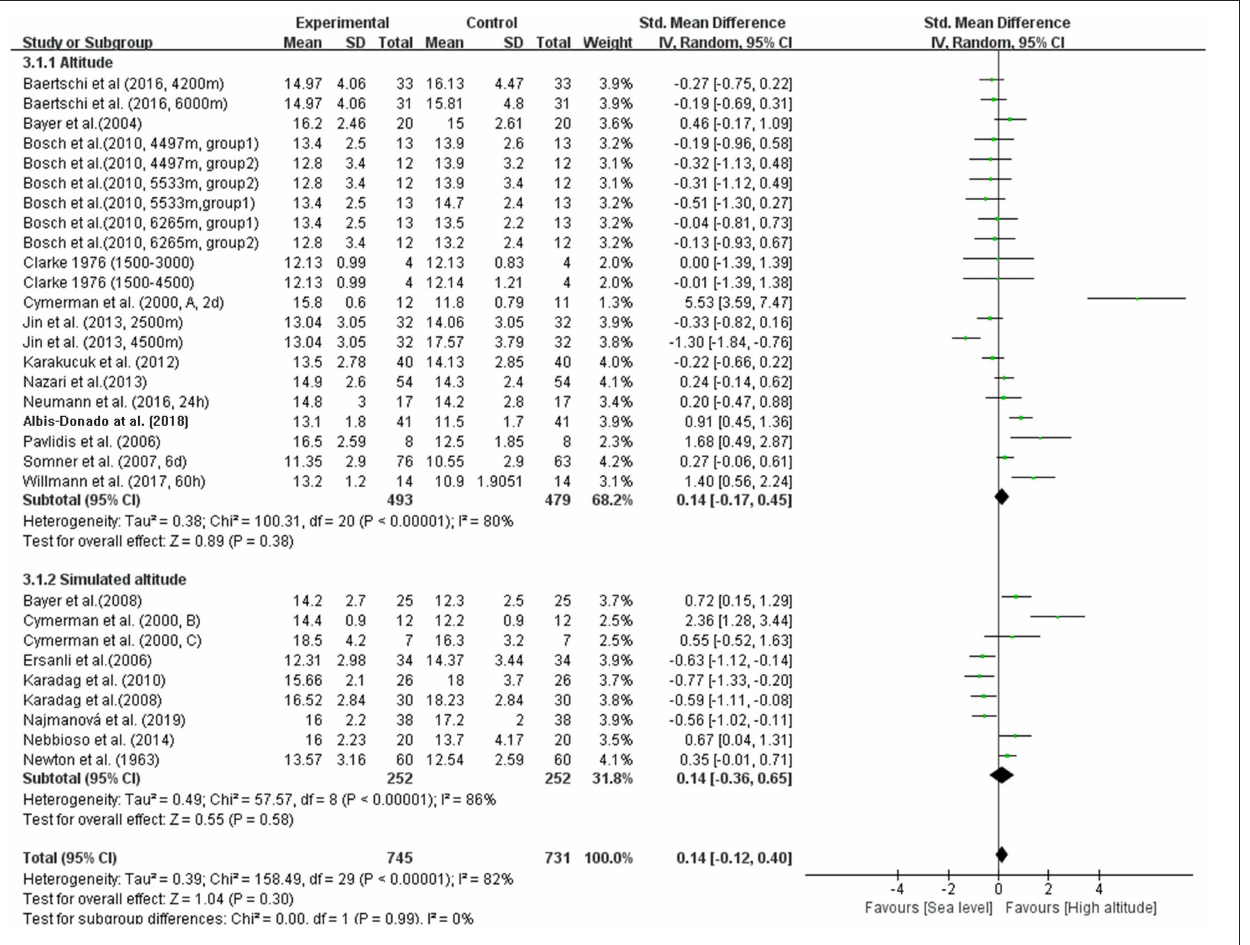
FIGURE 5 | Forest plot of subgroup analysis for real and simulated